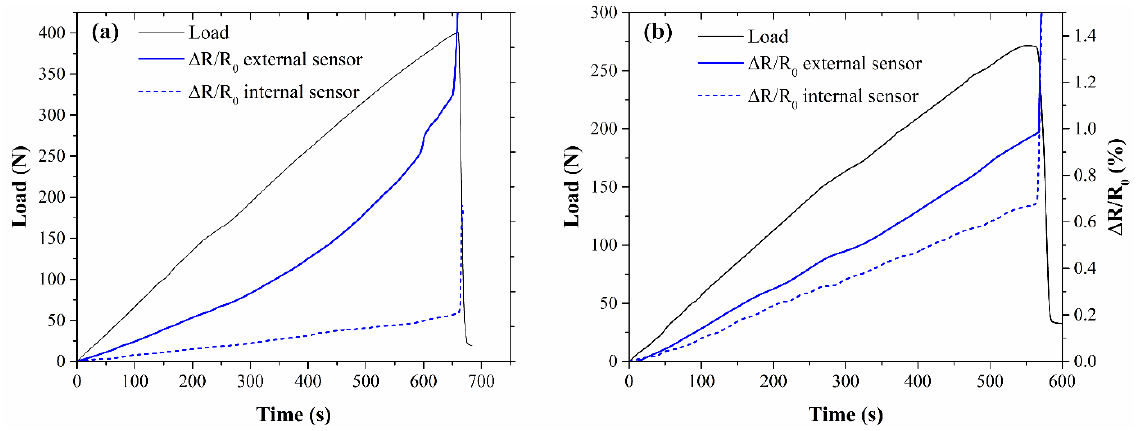
Figure 7. Self-monitoring behavior of ( a ) CB6_2, ( b ) CNT0.75_2 under monotonic bending tests. SMP sample are presented in Error! Reference source not found. . All curves show that [11,37]. After some cycles, however, a residual electrical resistance variation is present, which is ascribed to irreversible changes in the material, such as cracking and/or the plas- tic deformation of the resin [57]. No shouldered or double peak was detected, as opposed